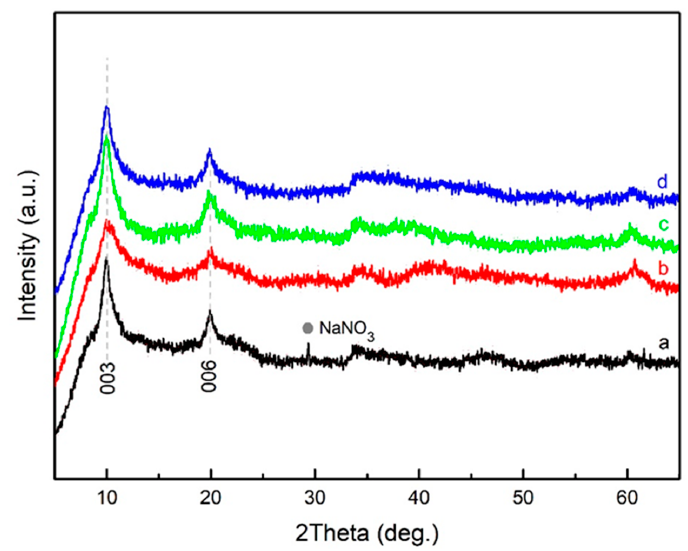
Figure 2. XRD patterns of the Co 2 Al–NO 3 LDHs synthesized using the conventional co-precipitation method and then either kept in a water bath at about 100 °C for 4 h (a) or sonicated at 1.5 kW for 2 min (b), 5 min (c), and 10 min (d).